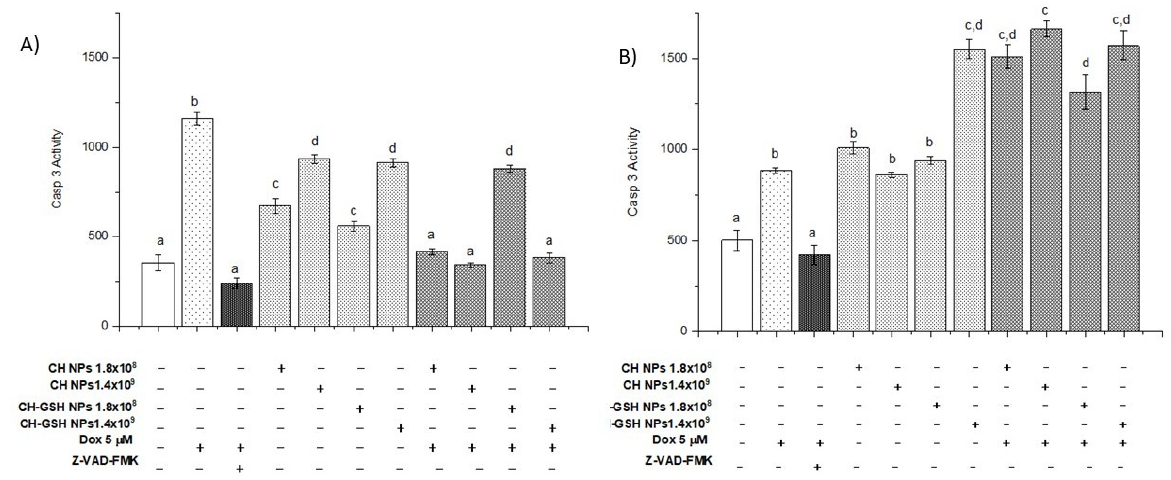
Figure 10. The activity of caspase-3. The cells were exposed to Dox for 12 h and then 2 h with CH-GSH NPs or CH-NPs. ( A ) MCF-7 and ( B ) MDA MB-231 cells. Bars with equal letters indicate no significant differences between the means (Tukey’s test, p <